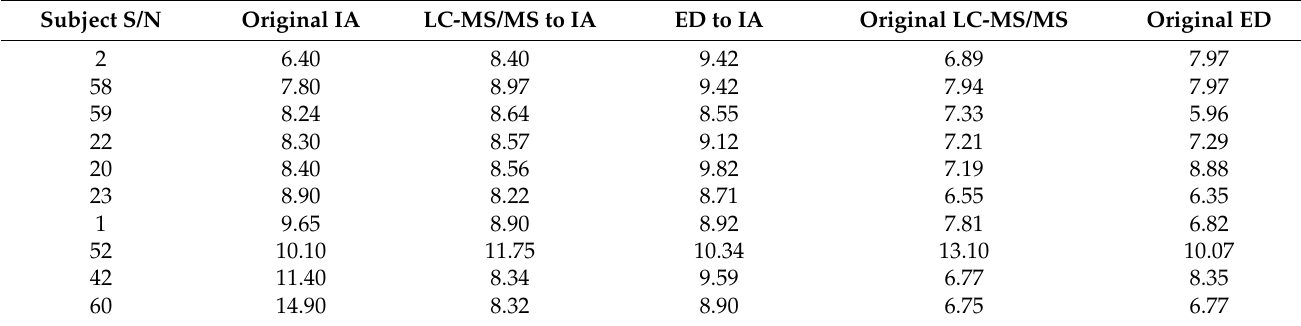
Figure 4. ( A – C ) Comparison between FT4 values with one method being the scale of reference and the transformed FT4 values from another two methods, using linear transformation. ( D – F ) Comparison between FT4 values with one method being the scale of interest and the transformed FT4 values with another two methods, using piecewise linear transformation. Blue represents the original data, while orange and grey represents corresponding data from two other methods transformed into the scale of the original using piece-wise linear transformation. Table 9. An example of FT4 values (pg/mL) measured by IA and transformations in LC-MS/MS and ED scales using linear transformation.